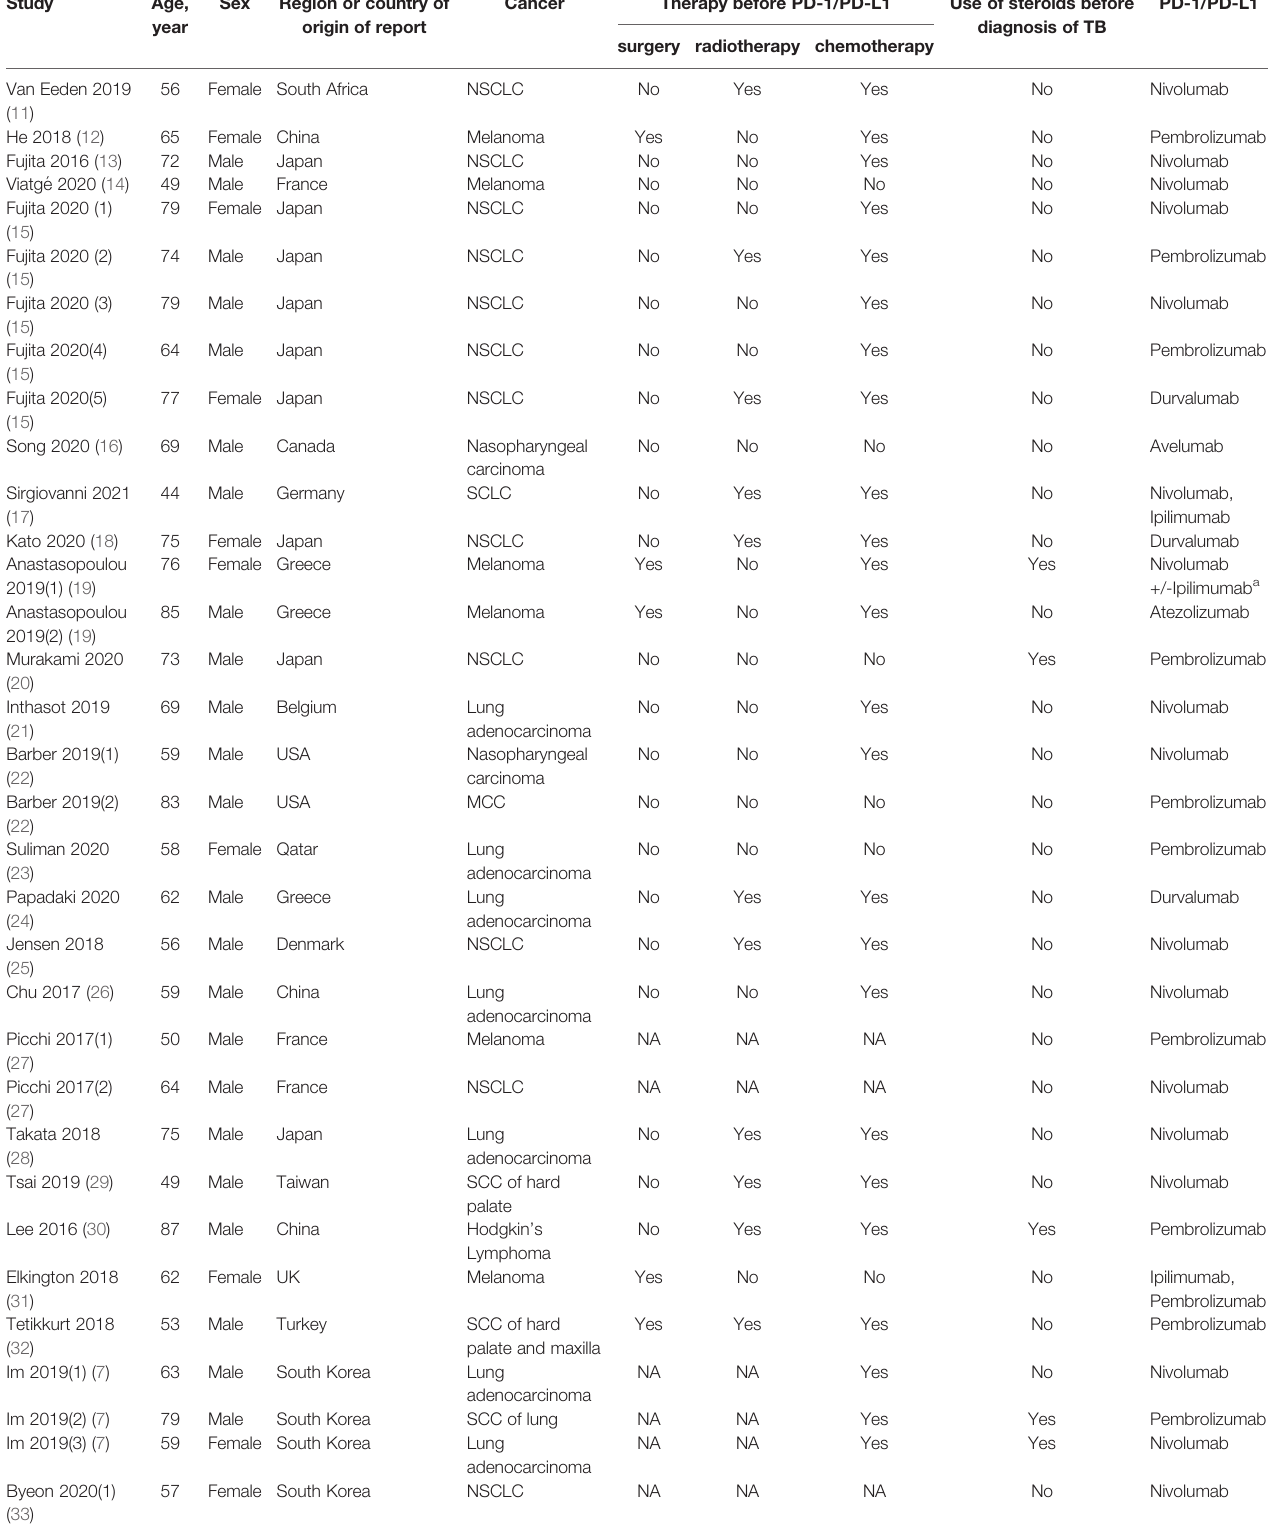
TABLE 1 | Baseline characteristics of patients included in our